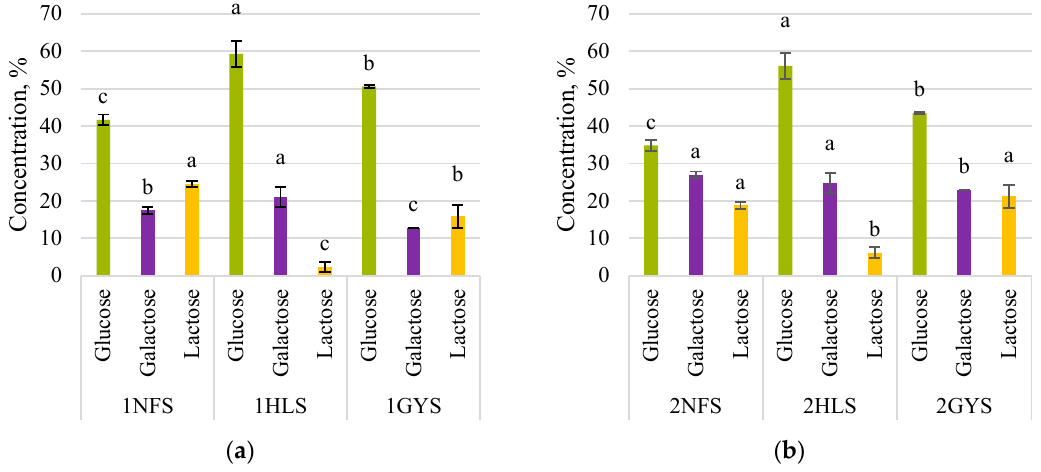
Figure 1. Sugars’ concentrations during 4 h of lactose hydrolysis. ( a )—sweet whey permeate 1GYS—GODO-YNL2; 1NFS—NOLA™ Fit5500; 1HLS—Ha-Lactase 5200. ( b )—acid whey permeate 2GYA—GODO-YNL2; 2NFA—NOLA™ Fit5500; 2HLA—Ha-Lactase 5200. The values marked with the same letter within each sugar do not differ significantly ( p > 0.05).